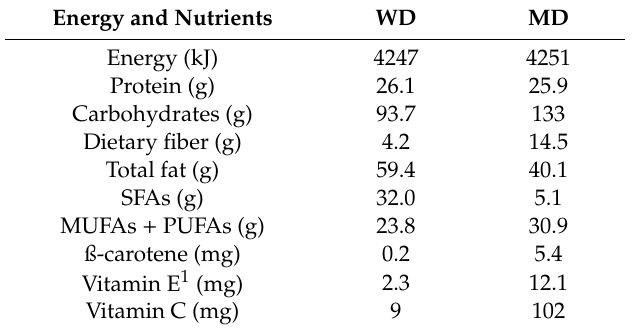
Table 1. Nutrient composition per serving of the two breakfast challenges (adapted from